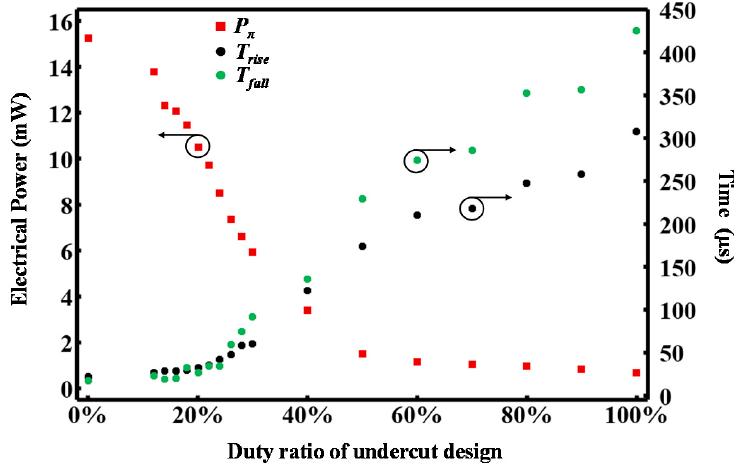
Figure 5. Summarized thermal tuning performance for the phase shifters with a different duty ratio D , including the electrical power consumption P π (red-dotted), rise time T rise (black-dotted) and fall time T fall (green-dotted).